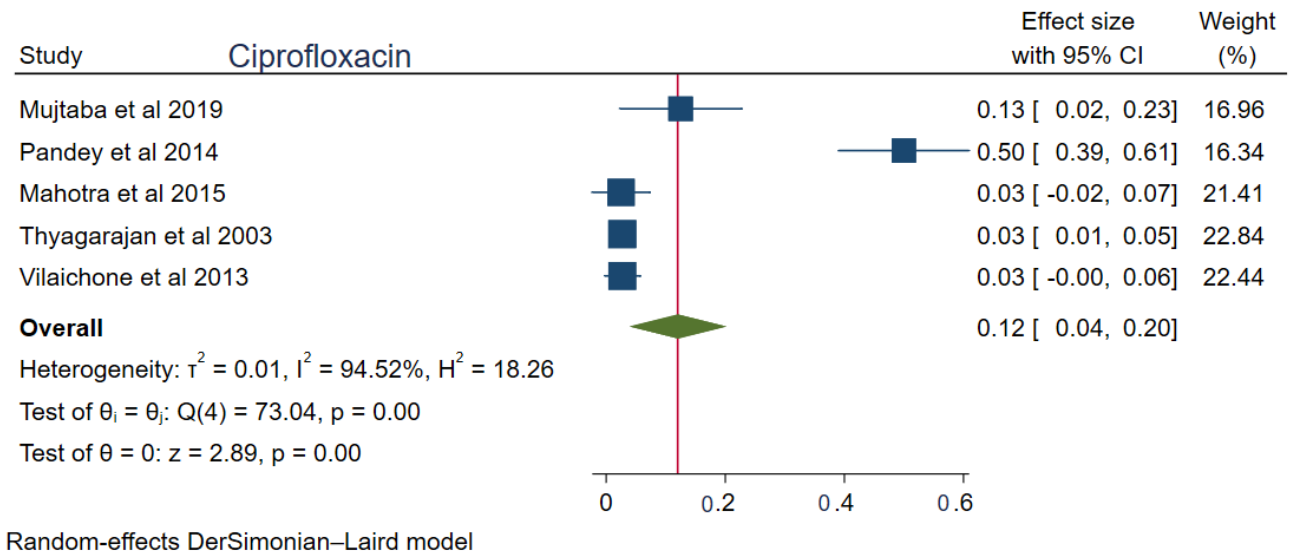
Figure 7. Forest Plot Showing Ciprofloxacin Resistance. (Reference studies: [21,23,27,36,37]).